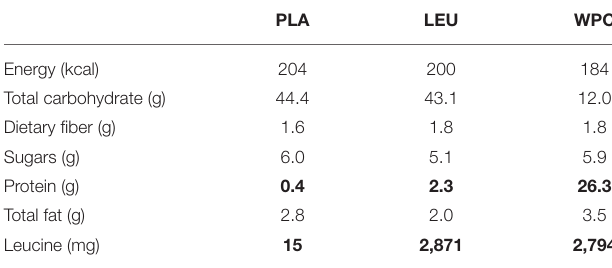
TABLE 1 | Macronutrient information per